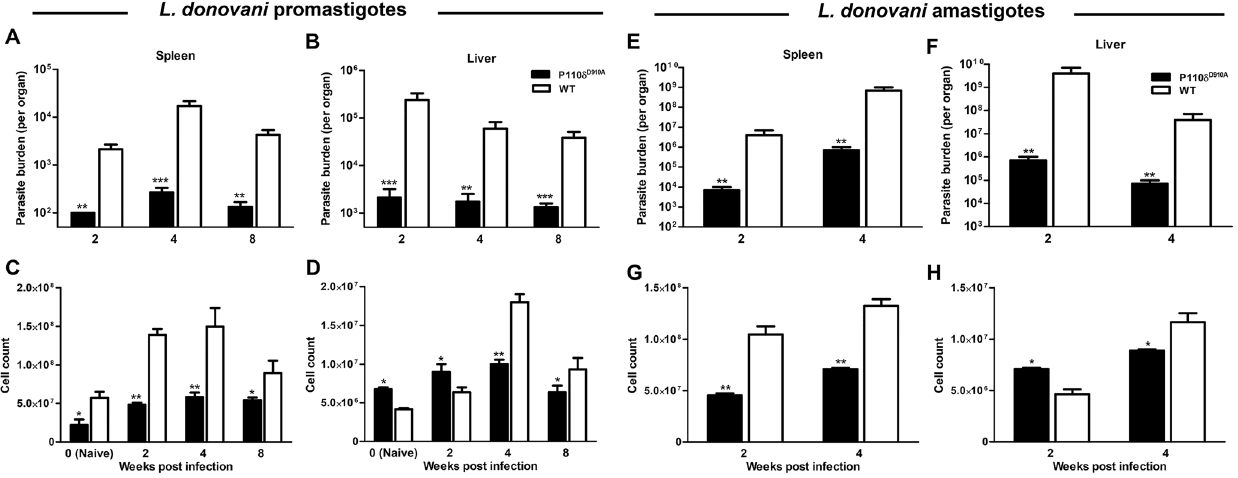
Figure 1. P110 d D910A mice are hyper-resistant to L.donovani . (A, B) Kinetics of parasite burden in the spleens and liver of WT and p110 d D910A BALB/c mice. Mice were infected with 5 6 10 7 stationary phase promastigotes (A, B) or 1 6 10 7 hamster spleen-derived amastigotes (E, F) and sacrificed at different times (as indicated) to assess parasite burden in the spleens (A, E) and liver (B, F). Total number of cells in the spleens (C, G) and liver (D, H) of WT and p110 d D910A mice at different times post-infection with promastigotes (C, D) or amastigotes (G, H). Results are representative of 6 (A–D) and 2 (E–H) independent experiments (n = 4 mice per group) with similar results. Error bars, + / 2 SEM; *, p , 0.05; **, p , 0.01; ***, p , 0.001.